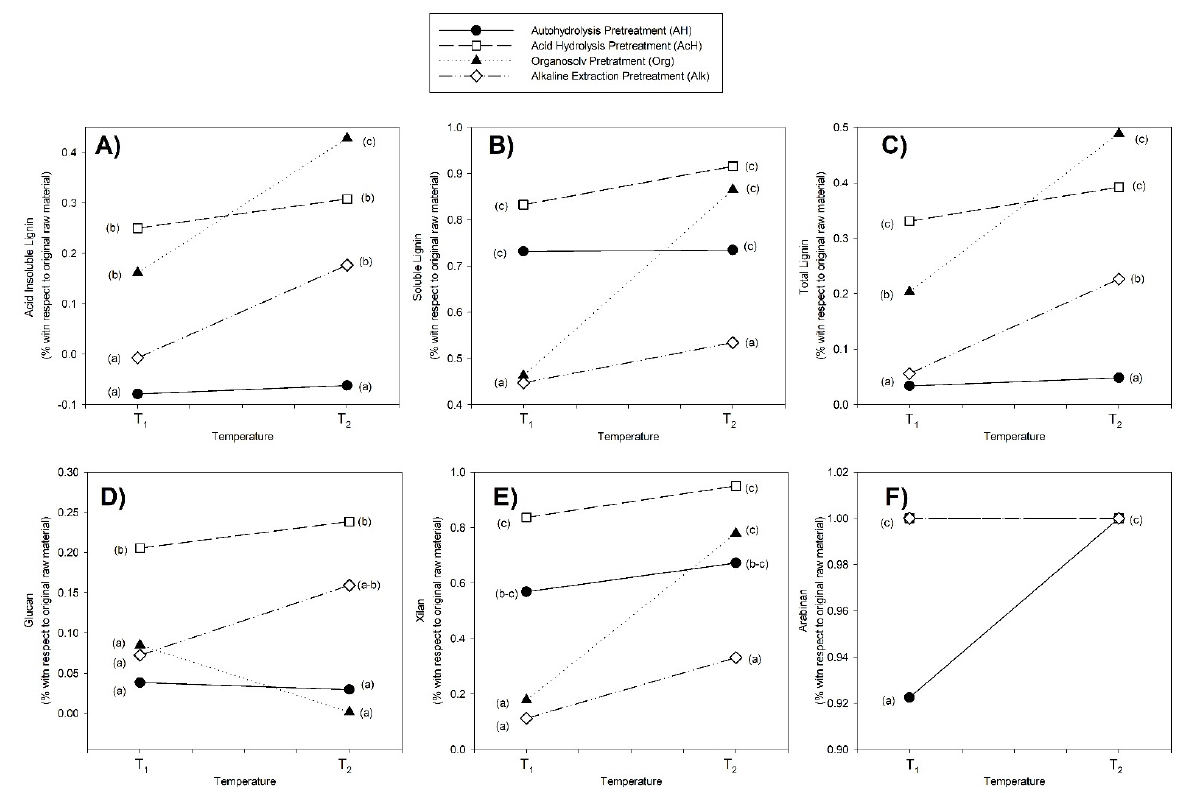
Figure 5. Analysis of lignin and carbohydrate extraction values per gram of each component in raw material according to the type of pretreatment and the temperatures at which they were taken: ( A ) acid insoluble lignin; ( B ) soluble lignin; ( C ) total lignin; ( D ) glucan; ( E ) xylan; ( F ) arabinan. T 1 , pretreatment temperatures at 160 ◦ C, except for alkaline extraction at 80 ◦ C. T 2 , pretreatment temperatures at 180 ◦ C, except for alkaline extraction at 160 ◦ C. Lines with the same letter for initial and final temperature are not significantly different (Tukey test, p < 0.05).